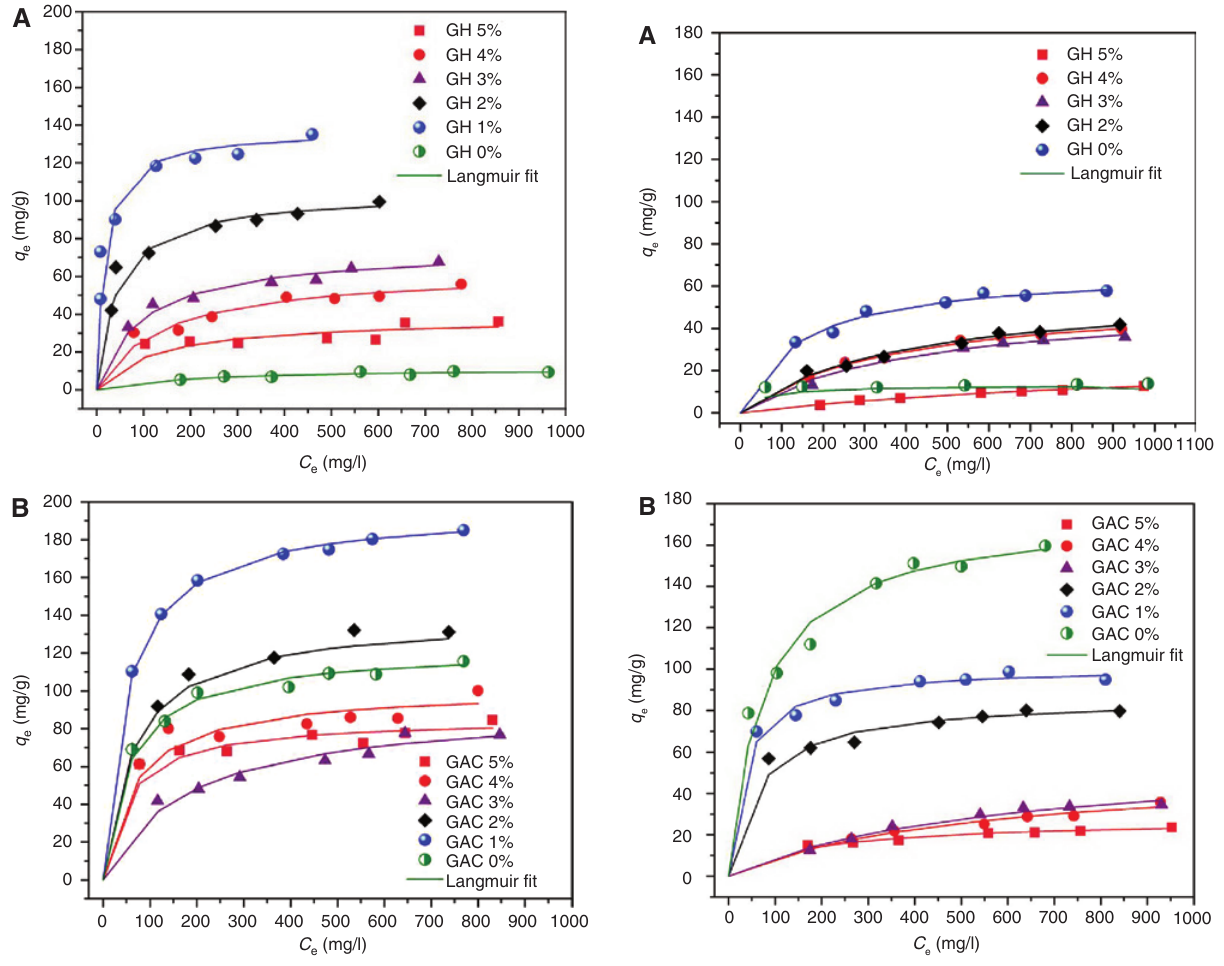
Figure 8: Adsorption isotherms of methylene green 5 (MG5) by various (A) glucose hydrochar and (B) activated carbon (AC)